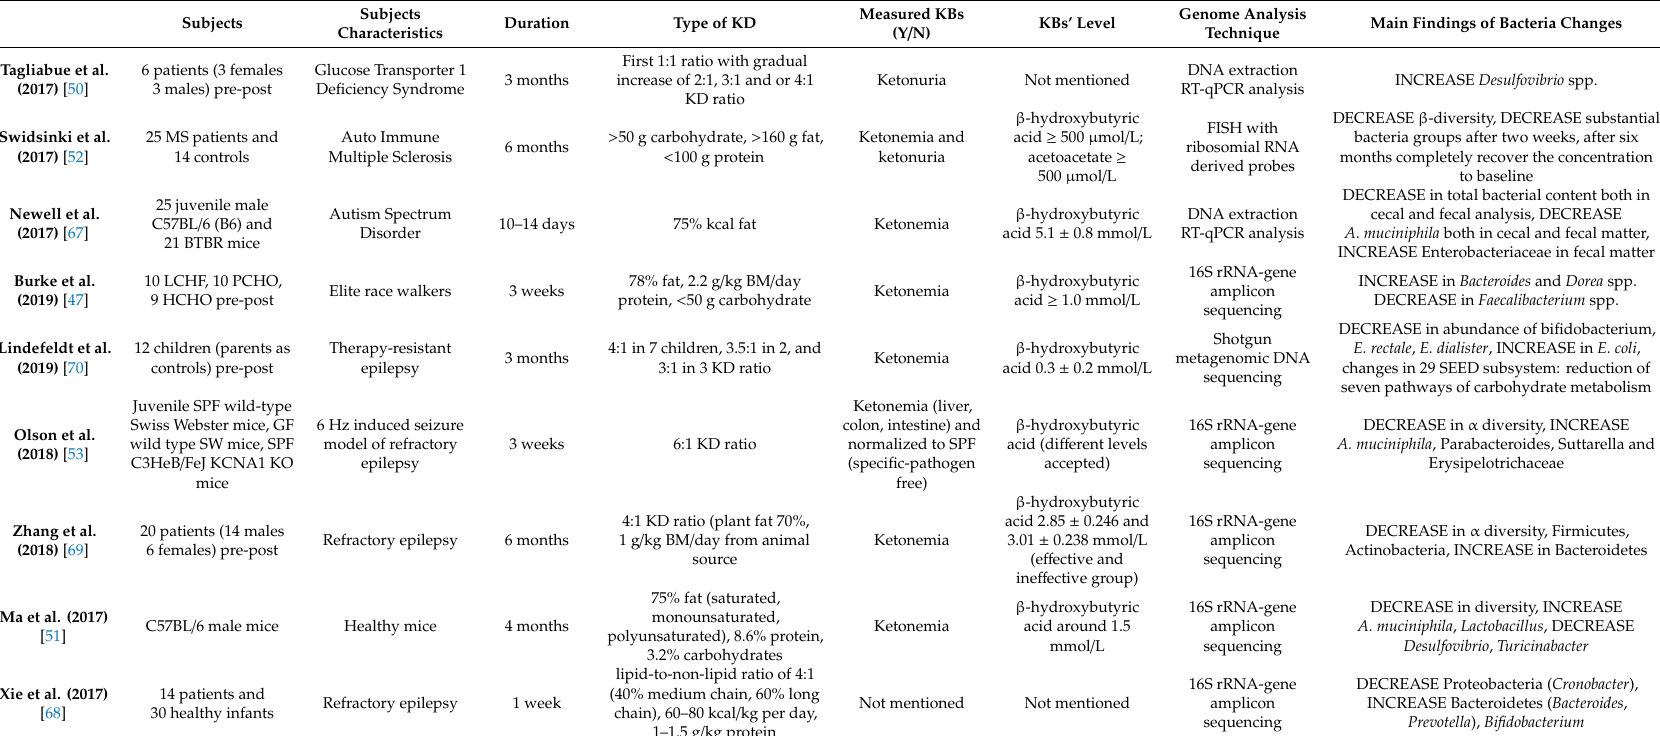
Table 1. Main findings of the e ff ects of Ketogenic diet (KD) on gut